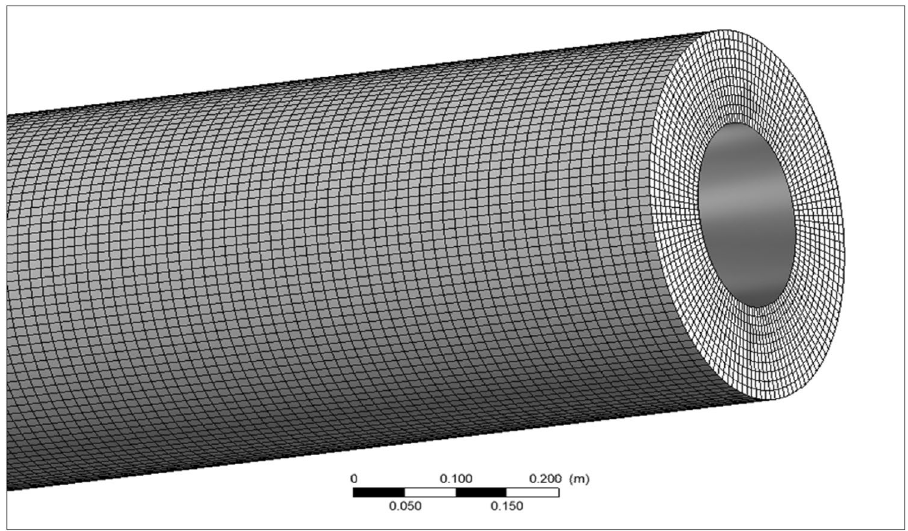
Fig. 5 Longitudinal cross sec- tion of the computational grid created on concentric wellbore- bit